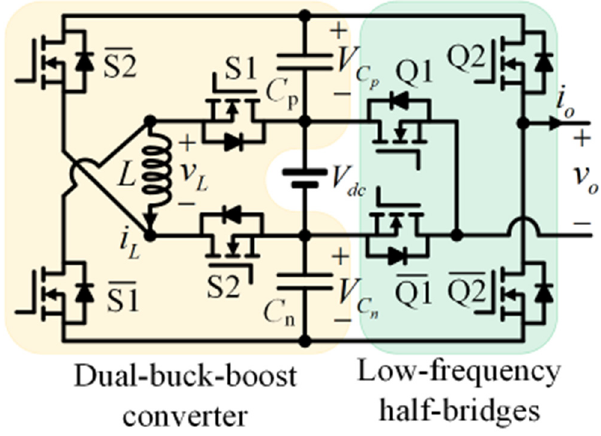
Figure 1. Proposed dual-buck-boost dc–dc/ac universal